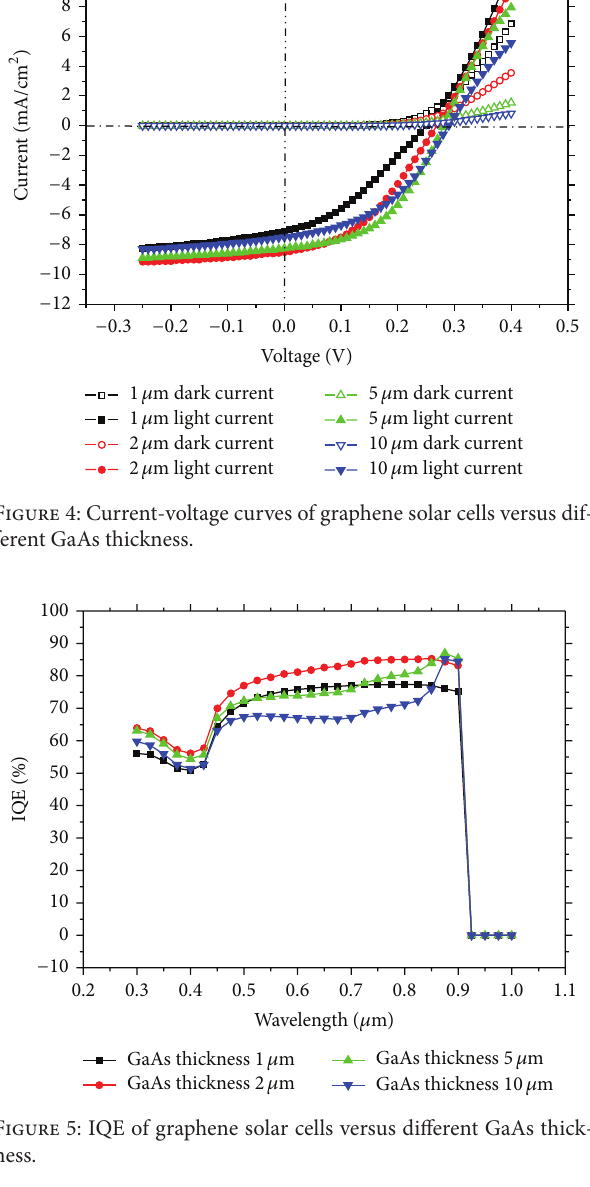
Figure 7: IQE of graphene solar cells versus different graphene work